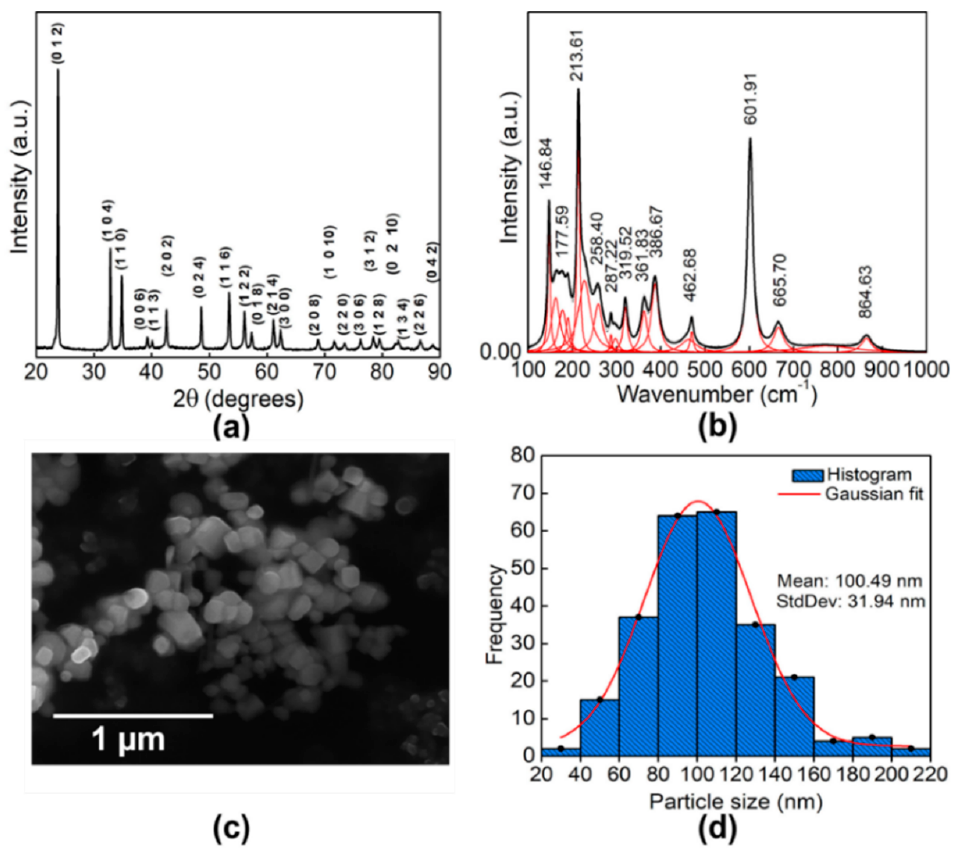
Figure 1. Structural and morphological characterization of LT NPs: ( a ) XRD pattern; ( b ) Raman spectrum; ( c ) SEM micrograph; ( d ) Particle size distribution.